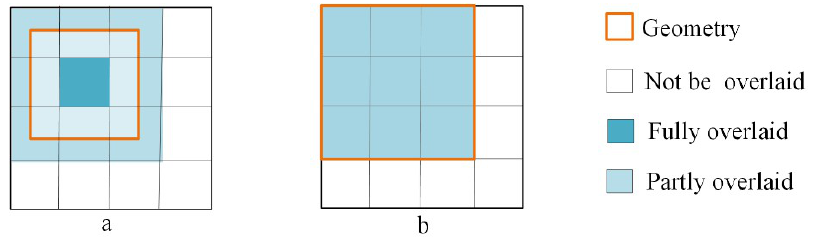
Figure 12. Grid-object spatial relationships at the last level: ( a ) partial coverage; ( b ) coverage. 2. Optimized the strategy on merging grid cell